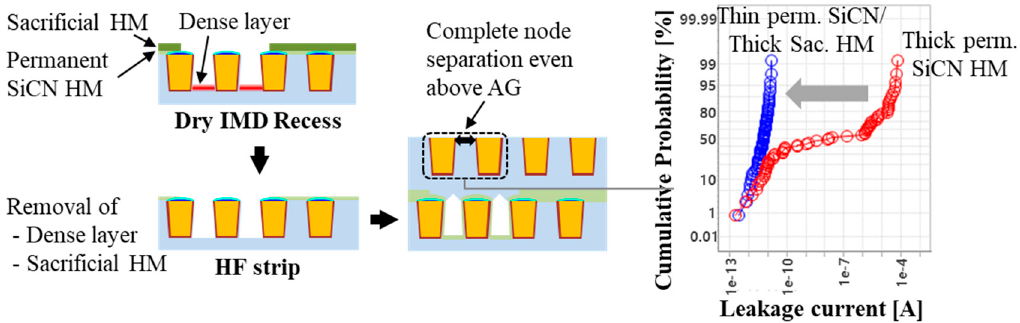
Figure 9. Leakage current of the minimum-pitched metal layer above AG for different HM schemes, and process flow of a sacrificial HM scheme.